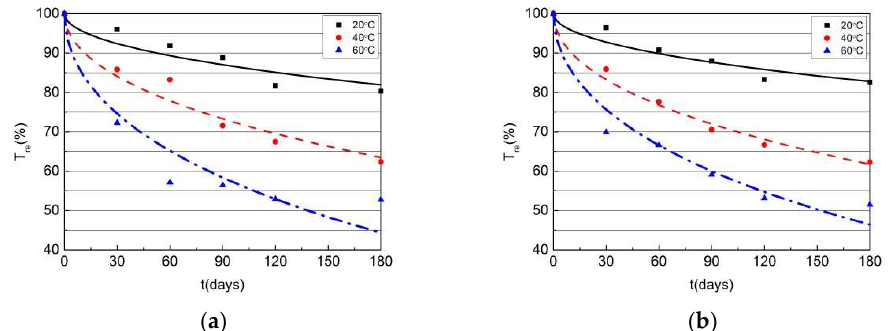
Figure 21. 𝑇 (cid:3045)(cid:3032) − 𝑡 fi(cid:308)ing curves based on the third model: ( a ) G1; ( b ) G2. Figure 21. T re − t fitting curves based on the third model: ( a ) G1; ( b ) As shown in Tables 8 and 9, the 𝑅 (cid:2870) of all the fi(cid:308)ing curves based on the third model were above 94% for both GFRP bars. Table 9. Values of √2𝐴𝐶 (G1).